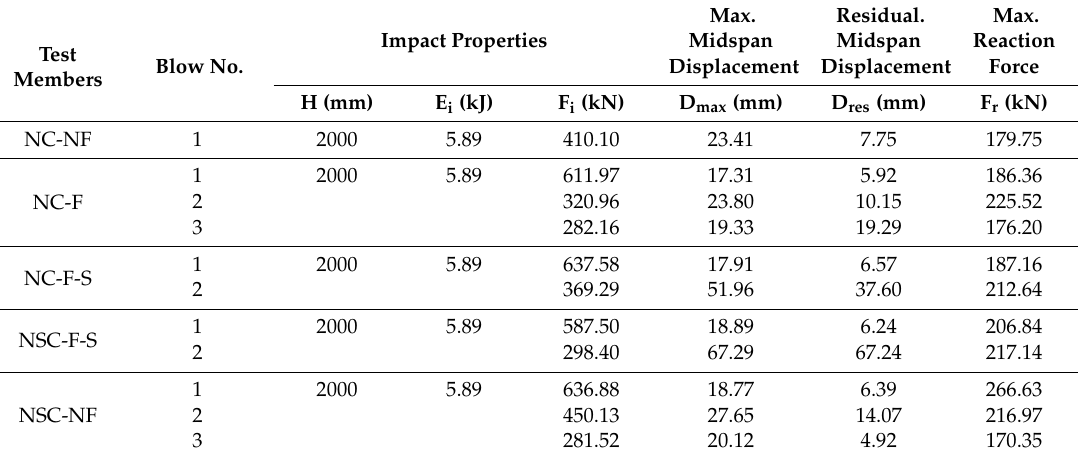
Table 7. Results of impact test of two-way